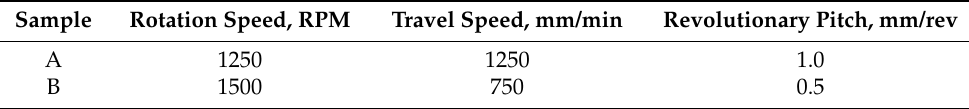
Table 2. Detailed welding parameters for further investigation.